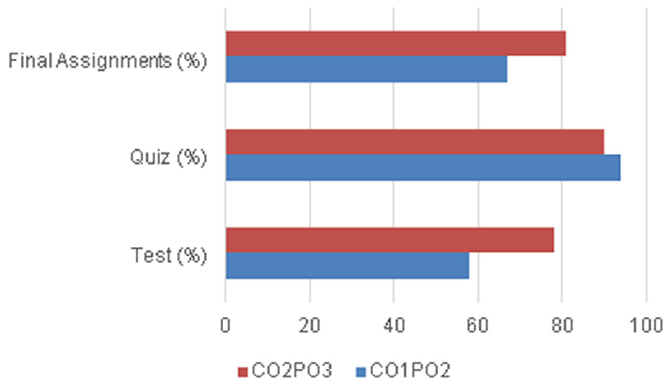
Fig. 5. Types of course evaluation